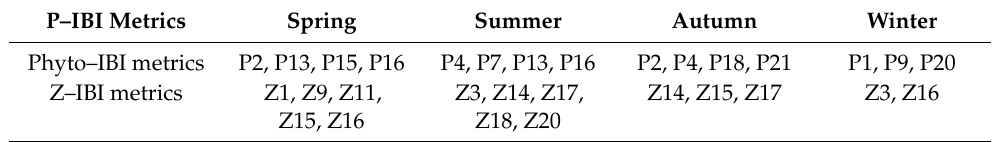
Table 1. Selected metrics for the P–IBI in different seasons.